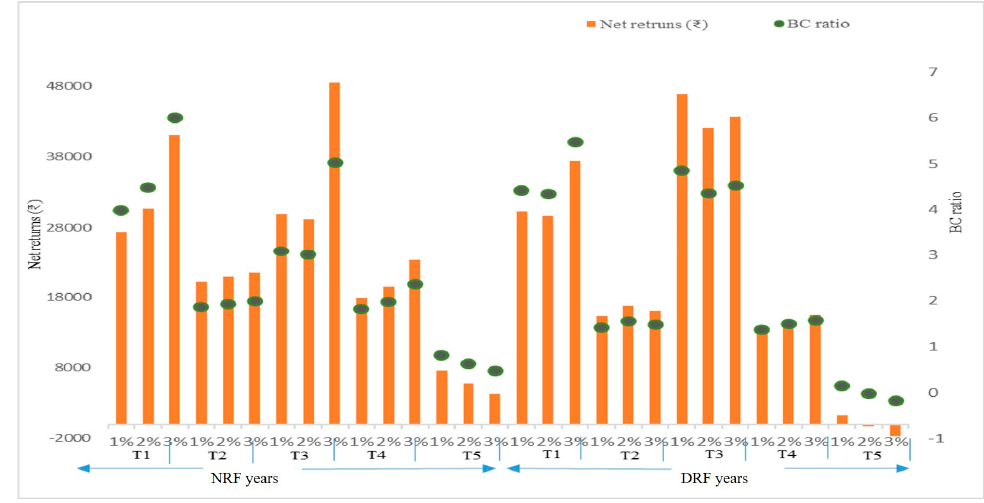
Figure 7. Effect of treatments on net returns across variable slopes (1–3%) in normal and deficit rainfall